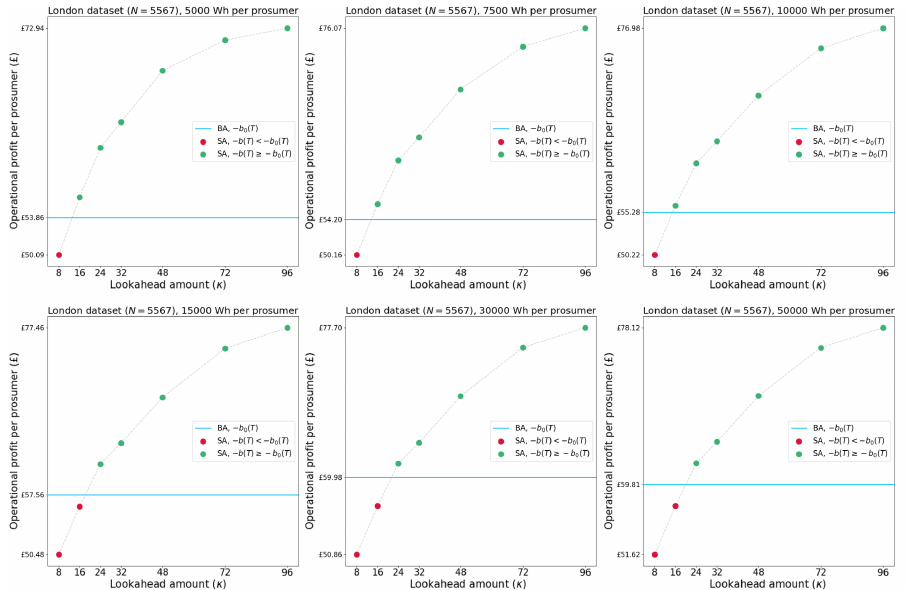
Figure A2. Part 2: Overview of operational profits per prosumer for the baseline and smart battery scheduling algorithm using various sizes for the lookahead window ( κ ) and various sizes for the battery per prosumer ( ω / N ) on original historical data of